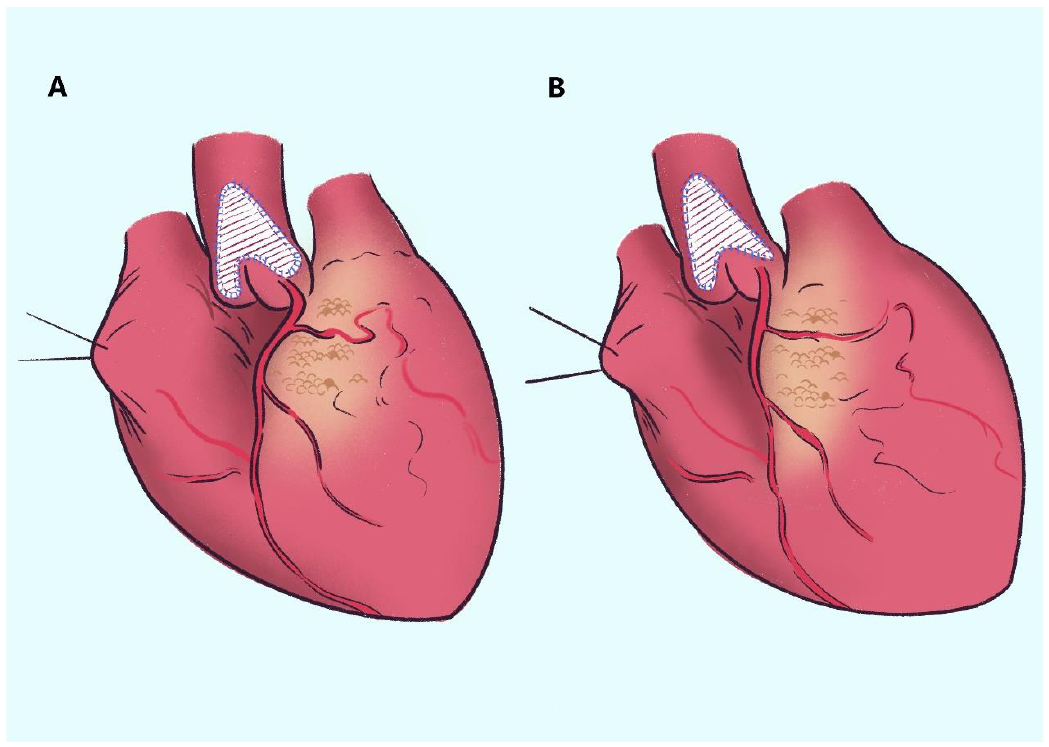
Figure 2. Adjustment of right coronary sinus patch. ( A ). Traditional technique. The right coronary sinus distorted after the traditional pantaloon-shaped patch; ( B ). Modified technique. A triangular patch is added to the right coronary sinus, with no displacement or deformation of the right coronary ostium.